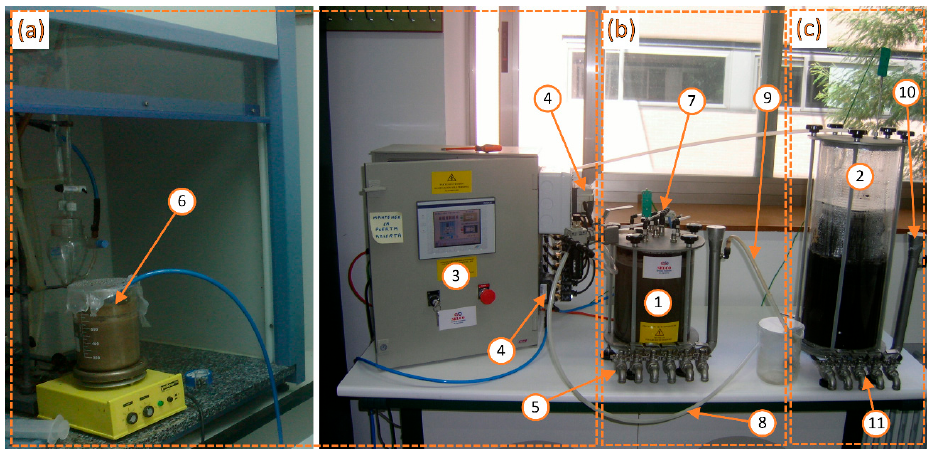
Figure 2. Continuous digester.